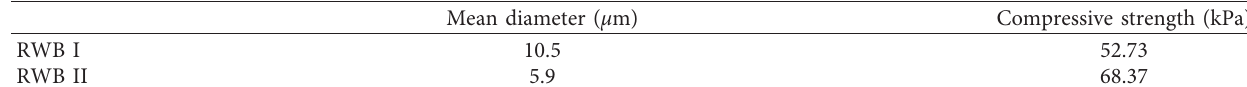
Figure 9: RWB model with different fiber diameter distributions (SVF � 4.72%): (a) fiber diameter � 3 μ m; (b) fiber diameter � 6 μ m; (c) fiber diameter � 10.5 μ m. Table 3: Compressive strength of RWBs with different diameter distributions.